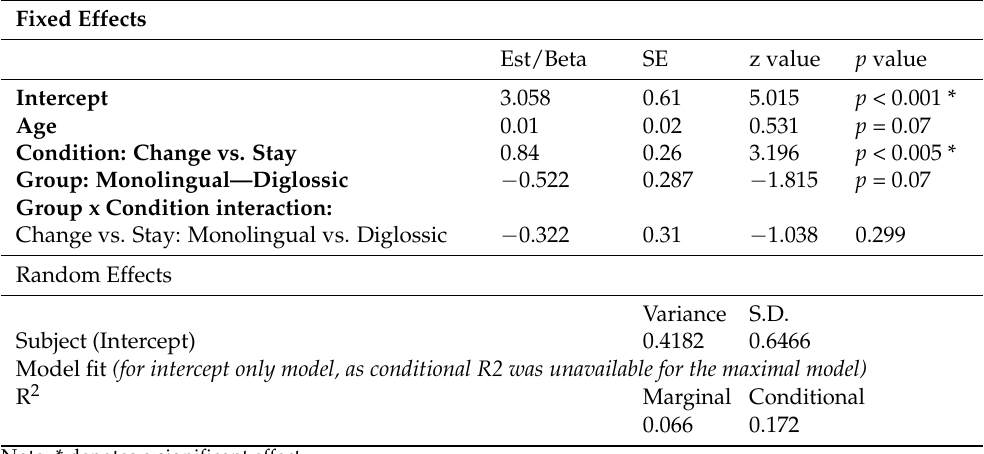
Table 5. Accuracy results for the Color-shape